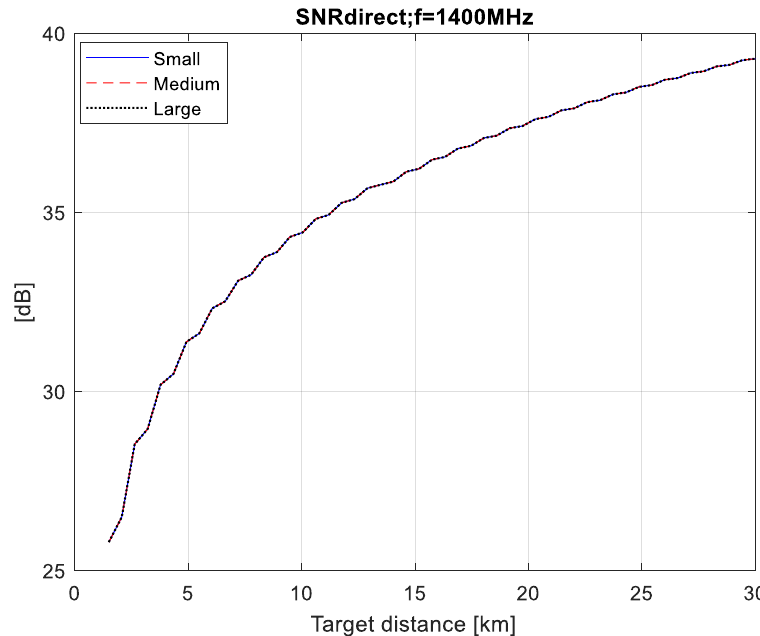
Figure 7. 𝑆𝑁𝑅 𝑑𝑖𝑟𝑒𝑐𝑡 values for pulsar FSR. Figure 7. SNR direct values for pulsar